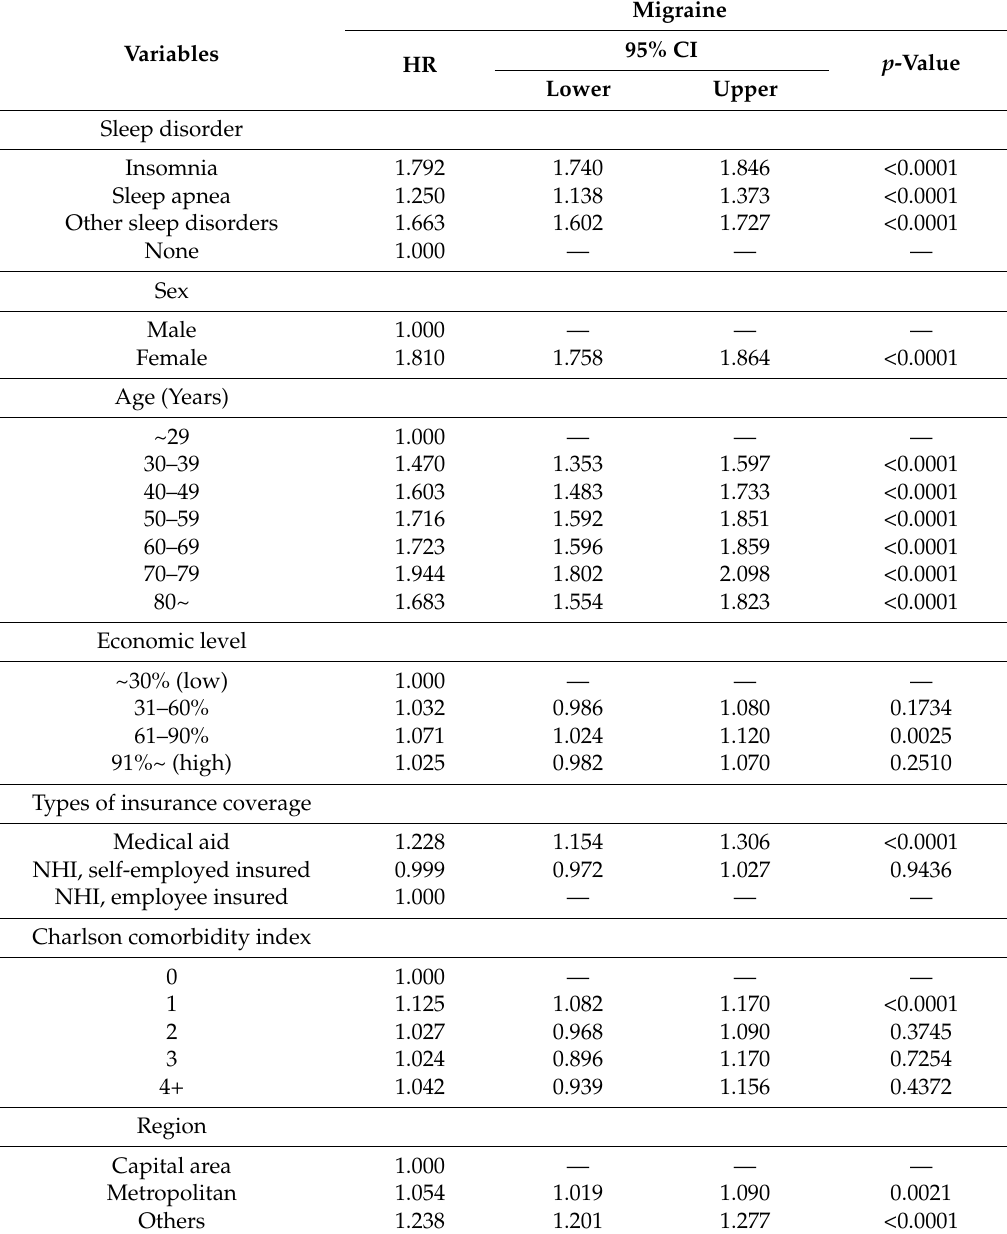
Table 3. Results of survival analysis for association between types of sleep disorder and